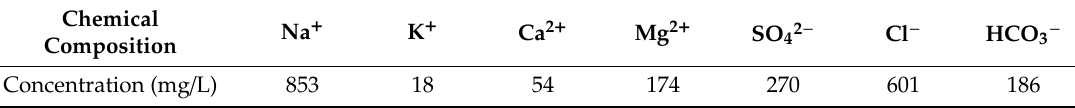
Table 2. Composition of injection and formation brine.